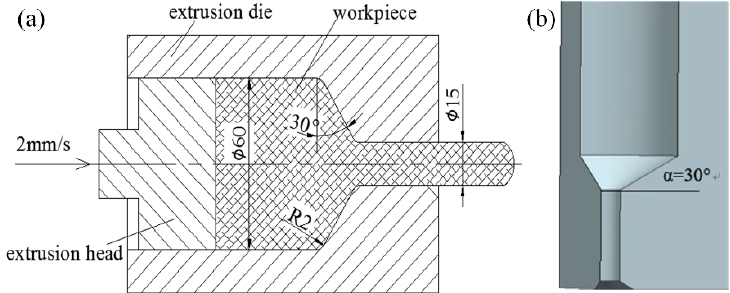
Figure 3. The schematic diagram of extrusion process: ( a ) pressure infiltration processing of the extrusion process; ( b ) 1/4 extrusion die of matrix composites interpenetrated by metal reinforcement (MIMC) composites.